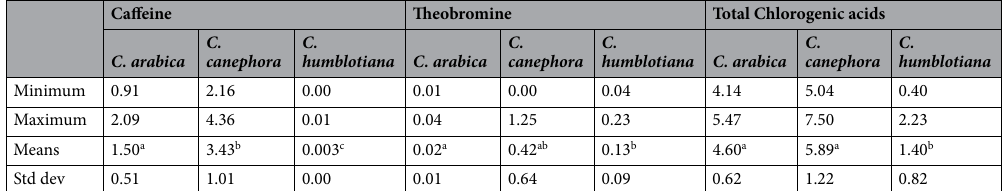
Table 3. Caffeine, theobromine and total chlorogenic acids contents on young leaves of C. arabica, C. canephora and C. humblotiana . The biochemical compounds are average of three genotypes for each Coffea species (Supplementary Table S3). Data are expressed in percent of dry matter basis (% dmb) and their class membership, according to Kruskal–Wallis test, is indicated by a letter. All tests were significant (P <